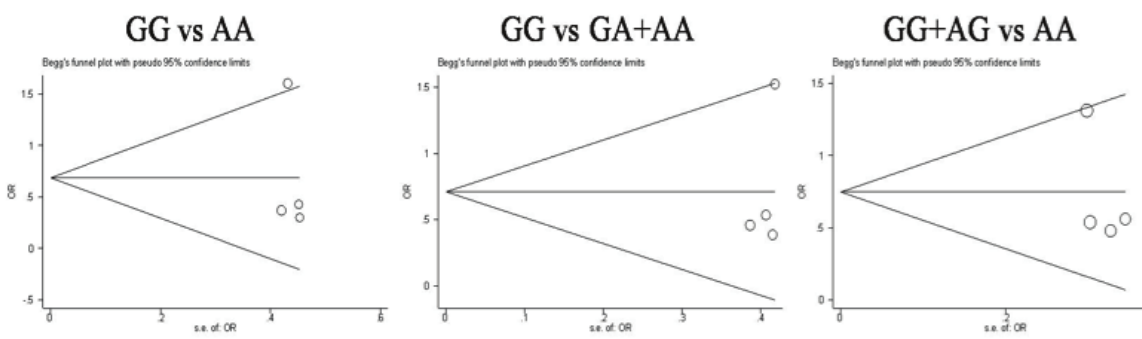
Figure 4: The funnel plot for publication bias